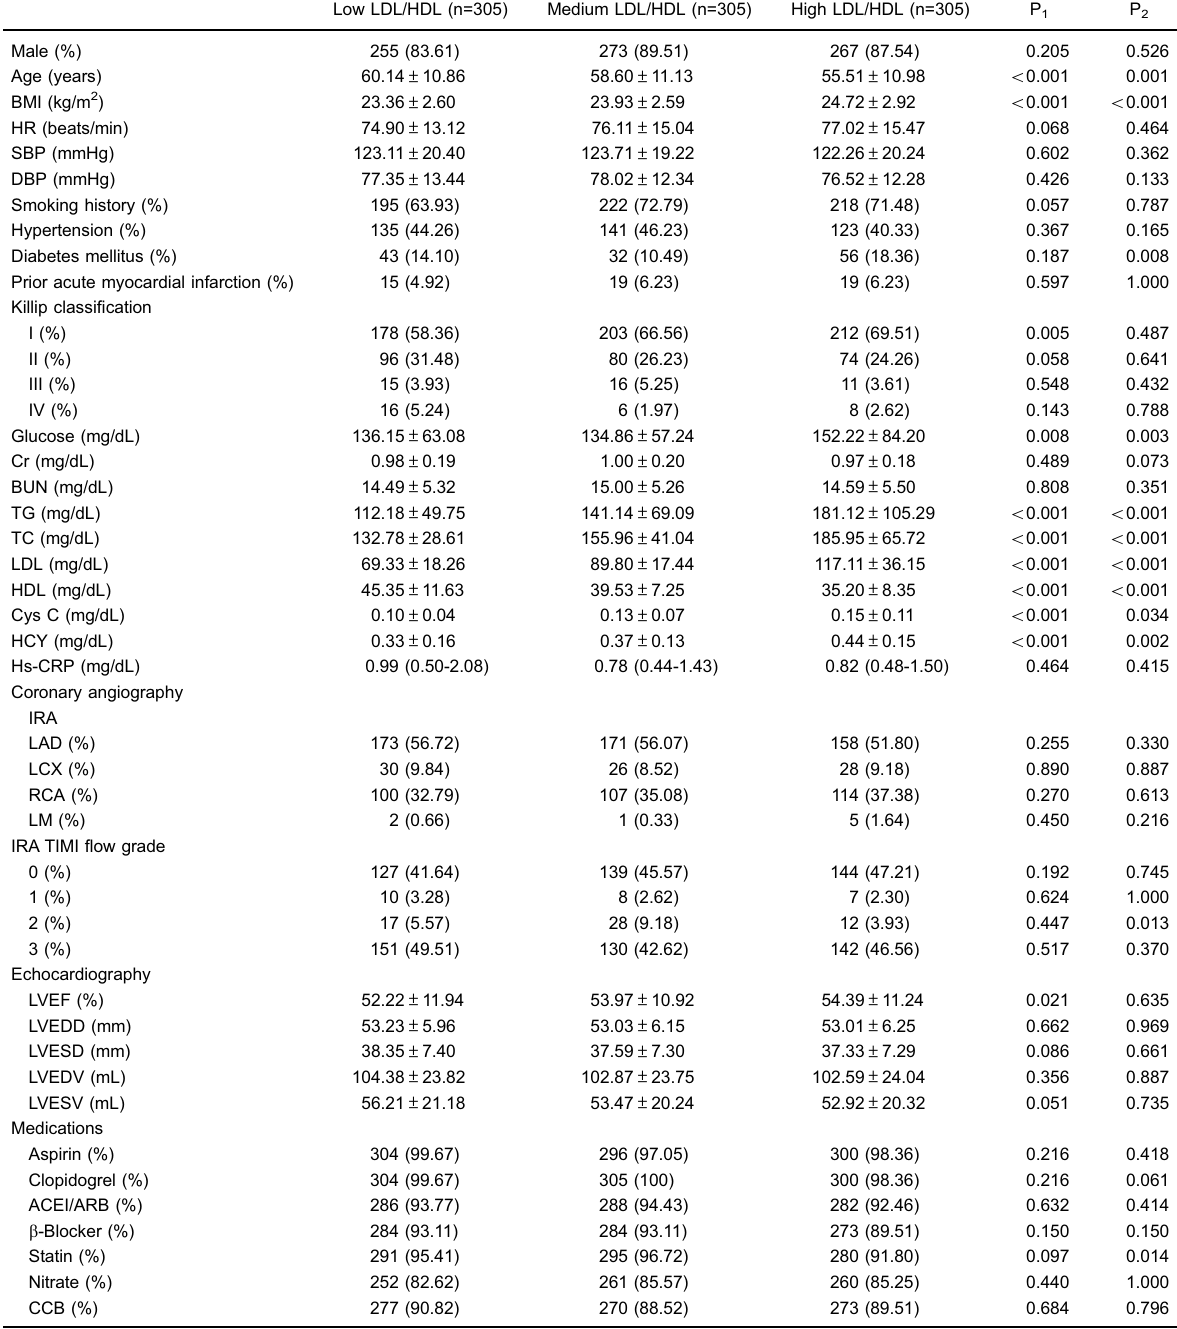
Table 1. Comparison of baseline data among the three